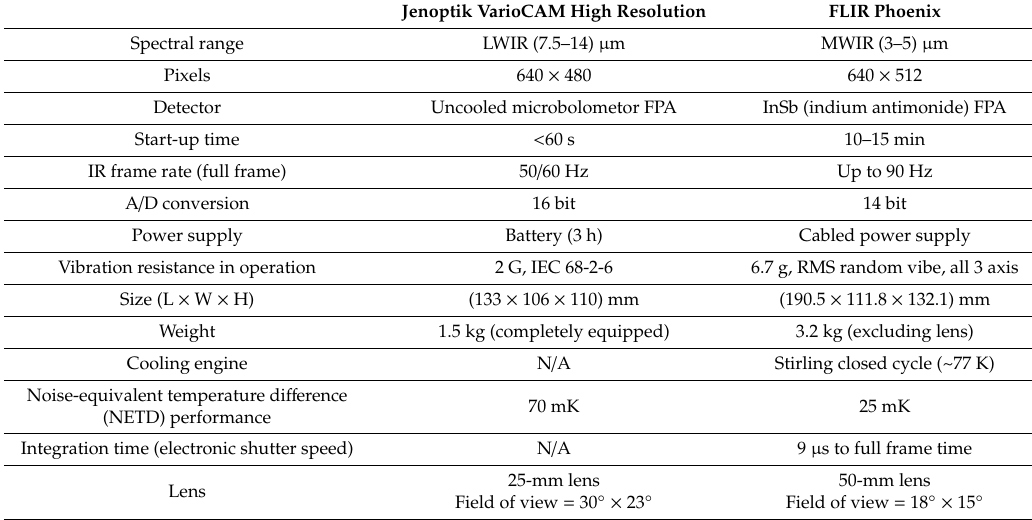
The table compares the specs of the two cameras which are used in the active thermographic non-destructive test of the aerospace grade composites [14,15]. FPA—focal plane array; A / D—analogue to digital; IEC—International Electrotechnical Commission; RMS—root mean square; N / A—not